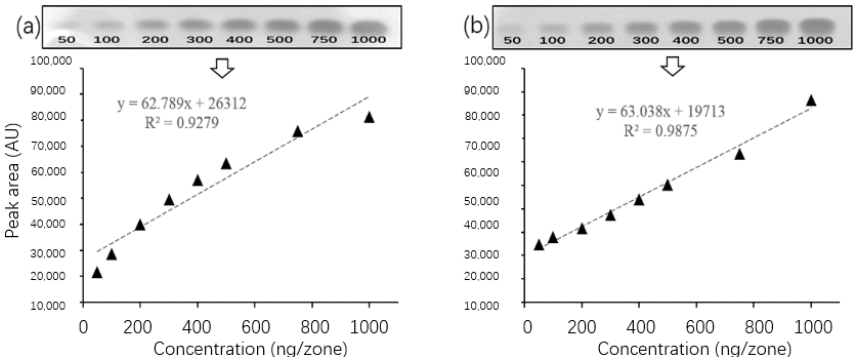
Figure 5. Does- dependence profile of inhibition zones caused by the analyte from 50 –1000 ng/zone: Figure 5. Does-dependence profile of inhibition zones caused by the analyte from 50–1000 ng/zone: ( a ) BZF and ( b ) CPF. ( a ) BZF and ( b ) CPF. Table 2. Accuracy evaluation of the established method. Table 2. Accuracy evaluation of the established method.